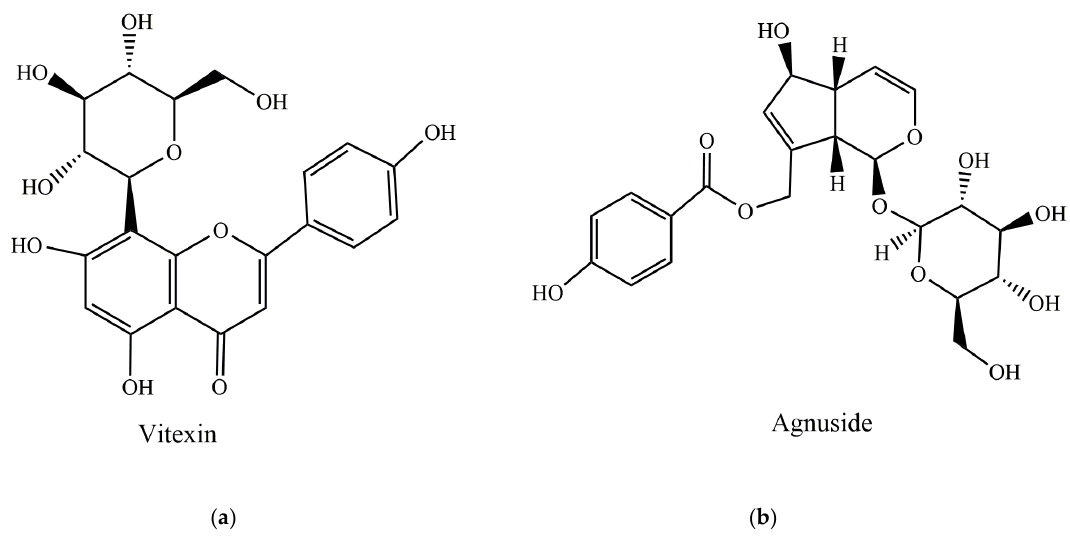
Figure 2. Chemical structure of vitexin ( a ) and of agnuside ( b ).